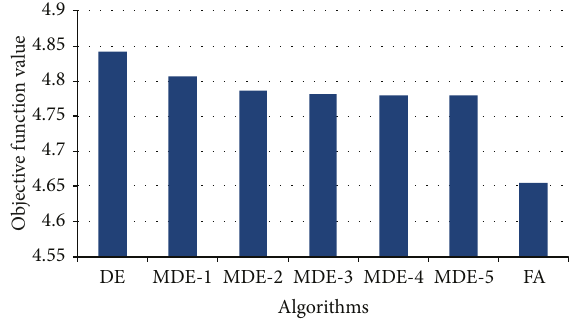
Figure 1: Best results obtained, for the IEEE 3-bus model, by dif- ferent techniques are compared with the firefly algorithm.